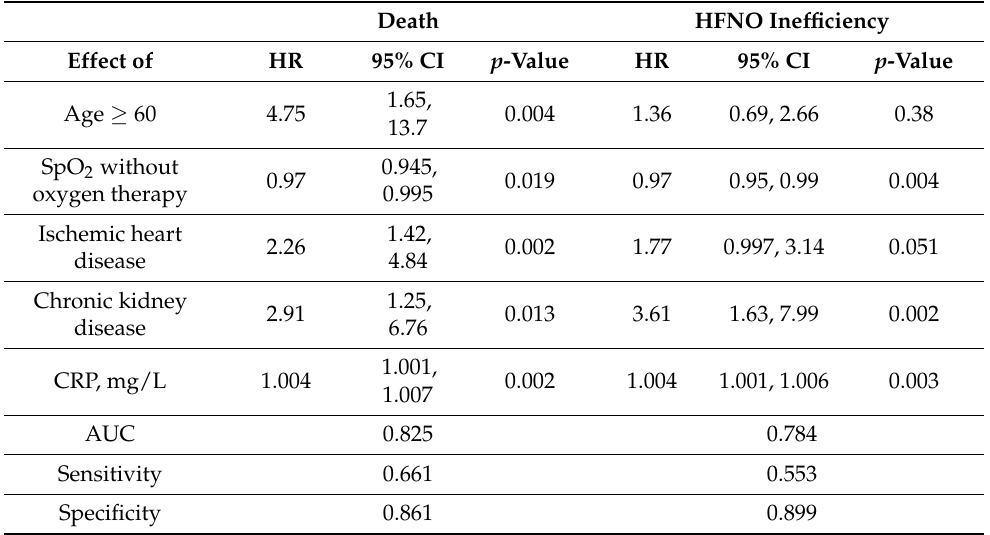
Table 4. Analysis of effect of SpO 2 without oxygen therapy on risk of death and HFNO inefficiency in a multifactor logistic regression model.